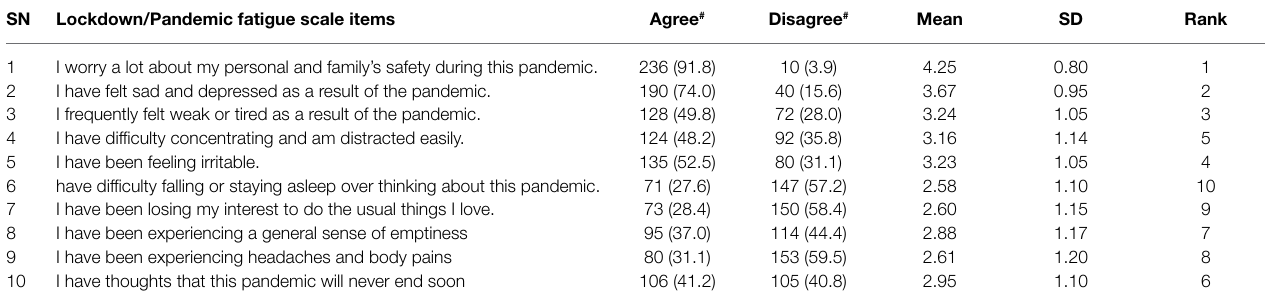
TABLE 3 | Response to lockdown/pandemic fatigue scale ( n = 256). Lockdown/Pandemic fatigue scale items